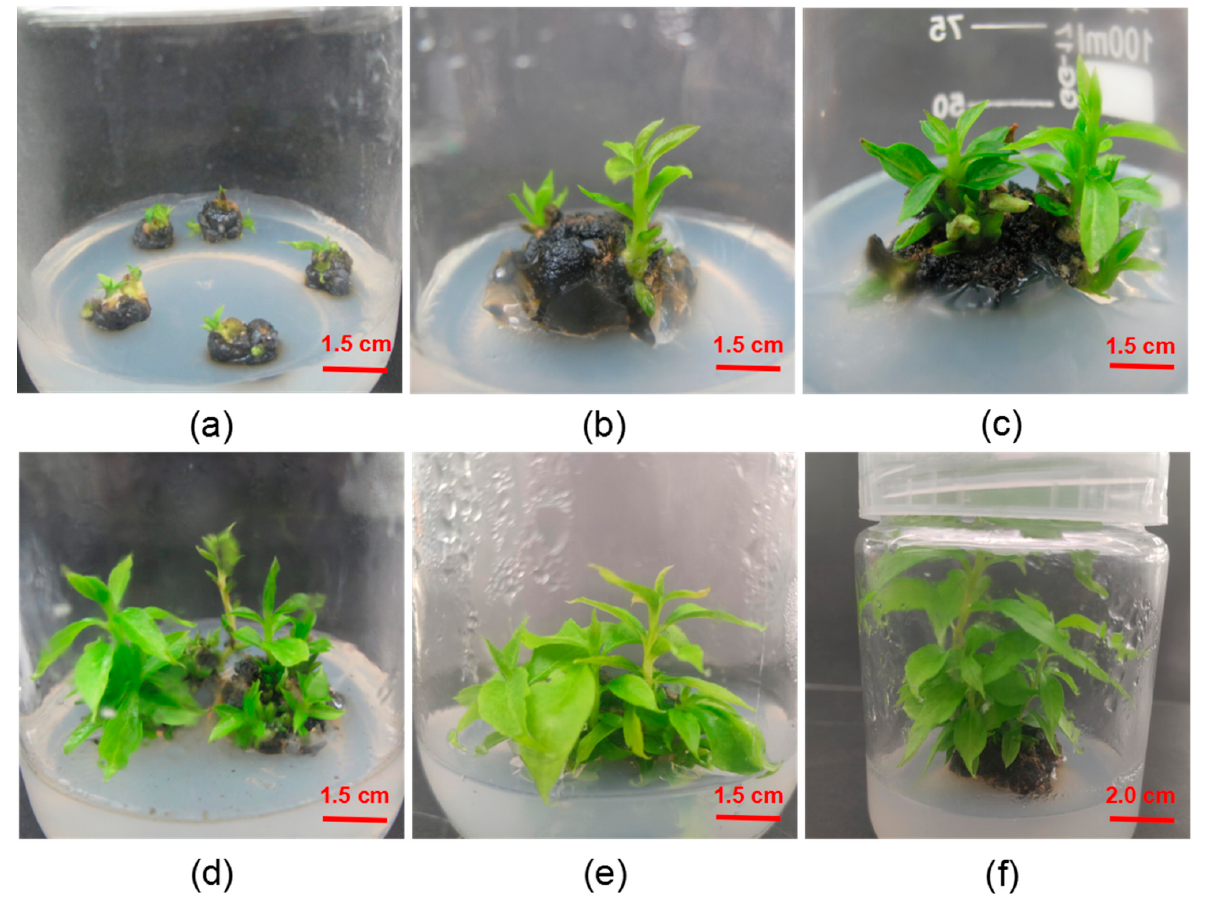
Figure 3. Callus and adventitious shoot induction from leaves in axillary buds of D. lotus . ( a ) Callus- induced adventitious shoots. Adventitious shoot growth after ( b ) 5 days, ( c ) 10 days, ( d ) 15 days, ( e ) 25 days, and ( f ) 30